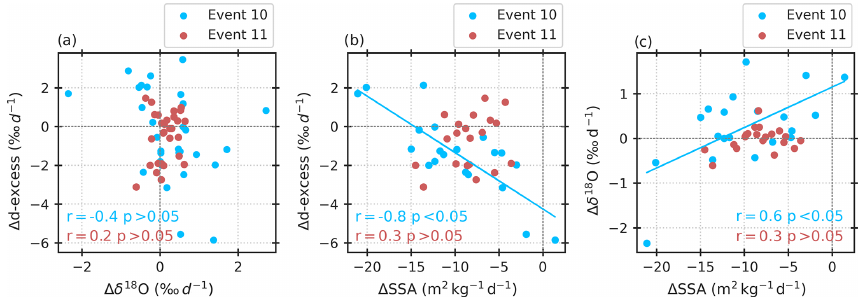
Figure 6. Isotopic change analysis for low-wind events, E10 and E11. Panel (a) shows daily change in d-excess against change in δ 18 O for E10 and E11, (b) shows change in d-excess against change in SSA, and (c) shows change in δ 18 O and change in SSA. The r and p values for each regression are indicated in the corresponding colours. Only significant linear regressions are indicated with a line.